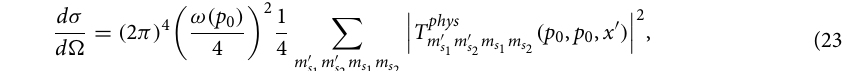
form of LS equations of Ref. 16 . The relativistic differential cross section of np elastic scattering as a function of the incident projectile energy is given by